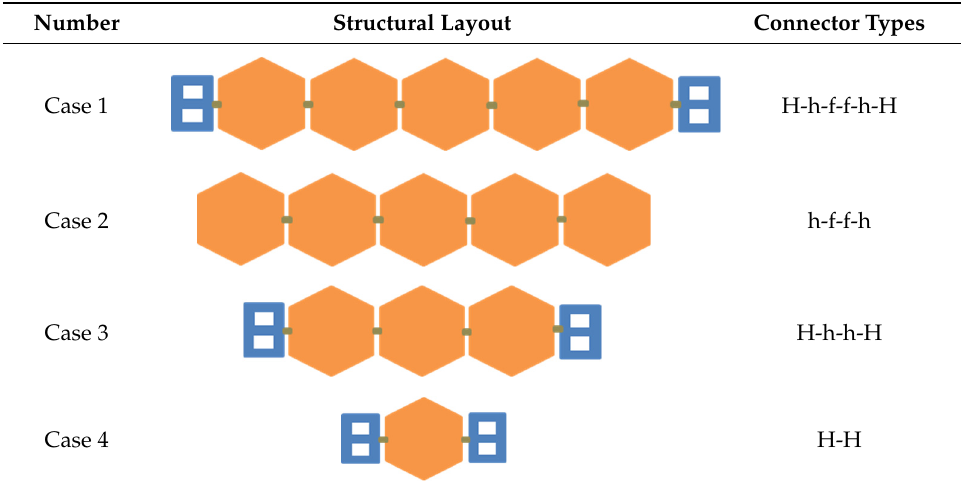
Table 2. Four structural layouts of the MFS system with different module numbers.